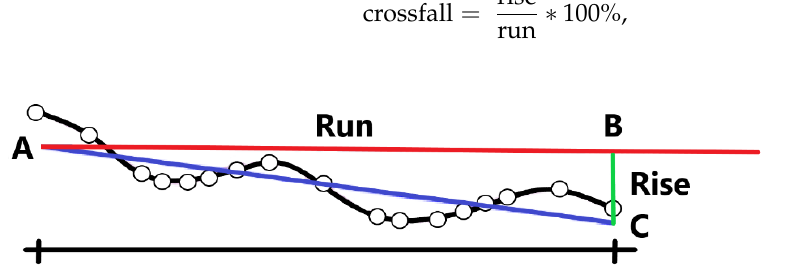
Figure 15. Crossfall measurement method.